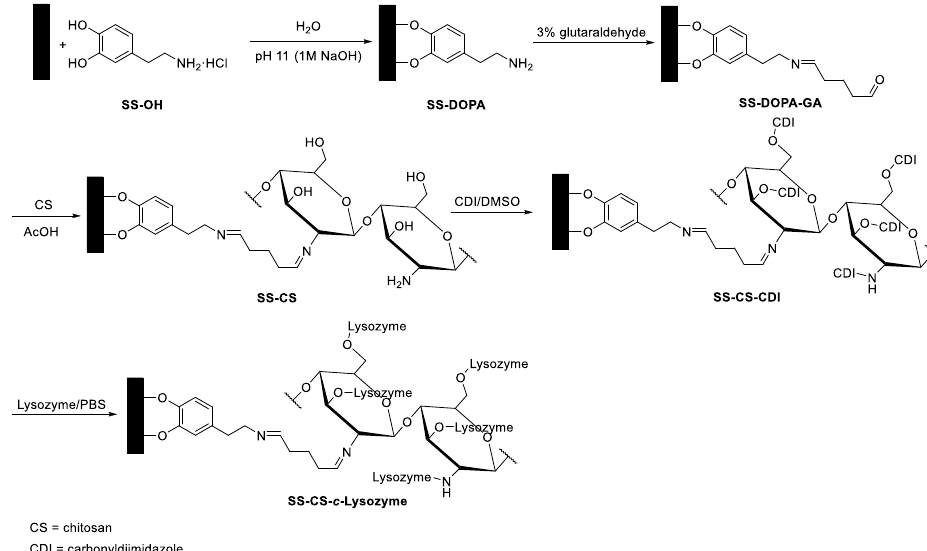
Figure 4. A schematic diagram illustrating the process of coupling dopamine, bifunctional cross- linker glutaraldehyde, chitosan, and lysozyme.